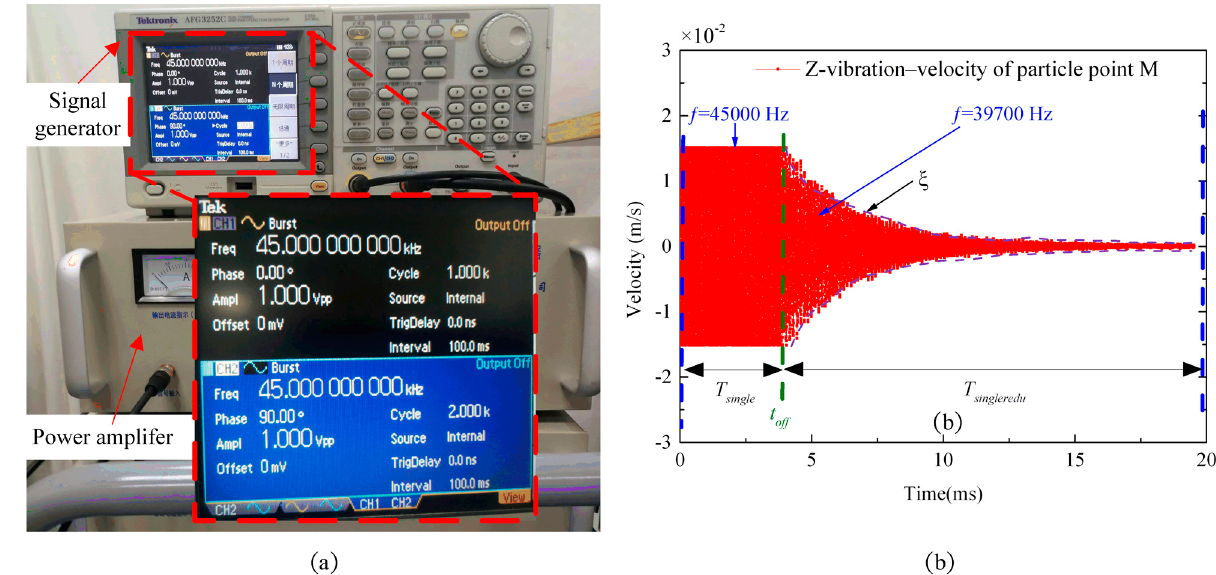
Figure 26. A stator single-phase vibration measurement experiment diagram: ( a ) vibration measurement fixture diagram;